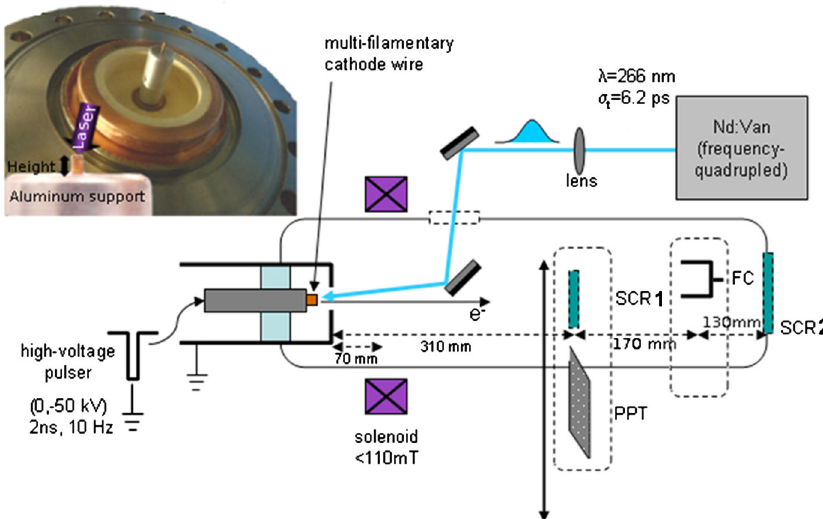
FIG. 1. The experimental setup of the 50 kVelectron gun, used to measure the beam charge and the emittance. PPT is the pepperpot for measuring the beam emittance, SCR1 is a Ce:YAG screen, FC is the Faraday cup for measuring the beam charge, and SCR2 is a phosphor screen at the end of the vacuum chamber. The inset shows the cathode with the aluminum support and wire